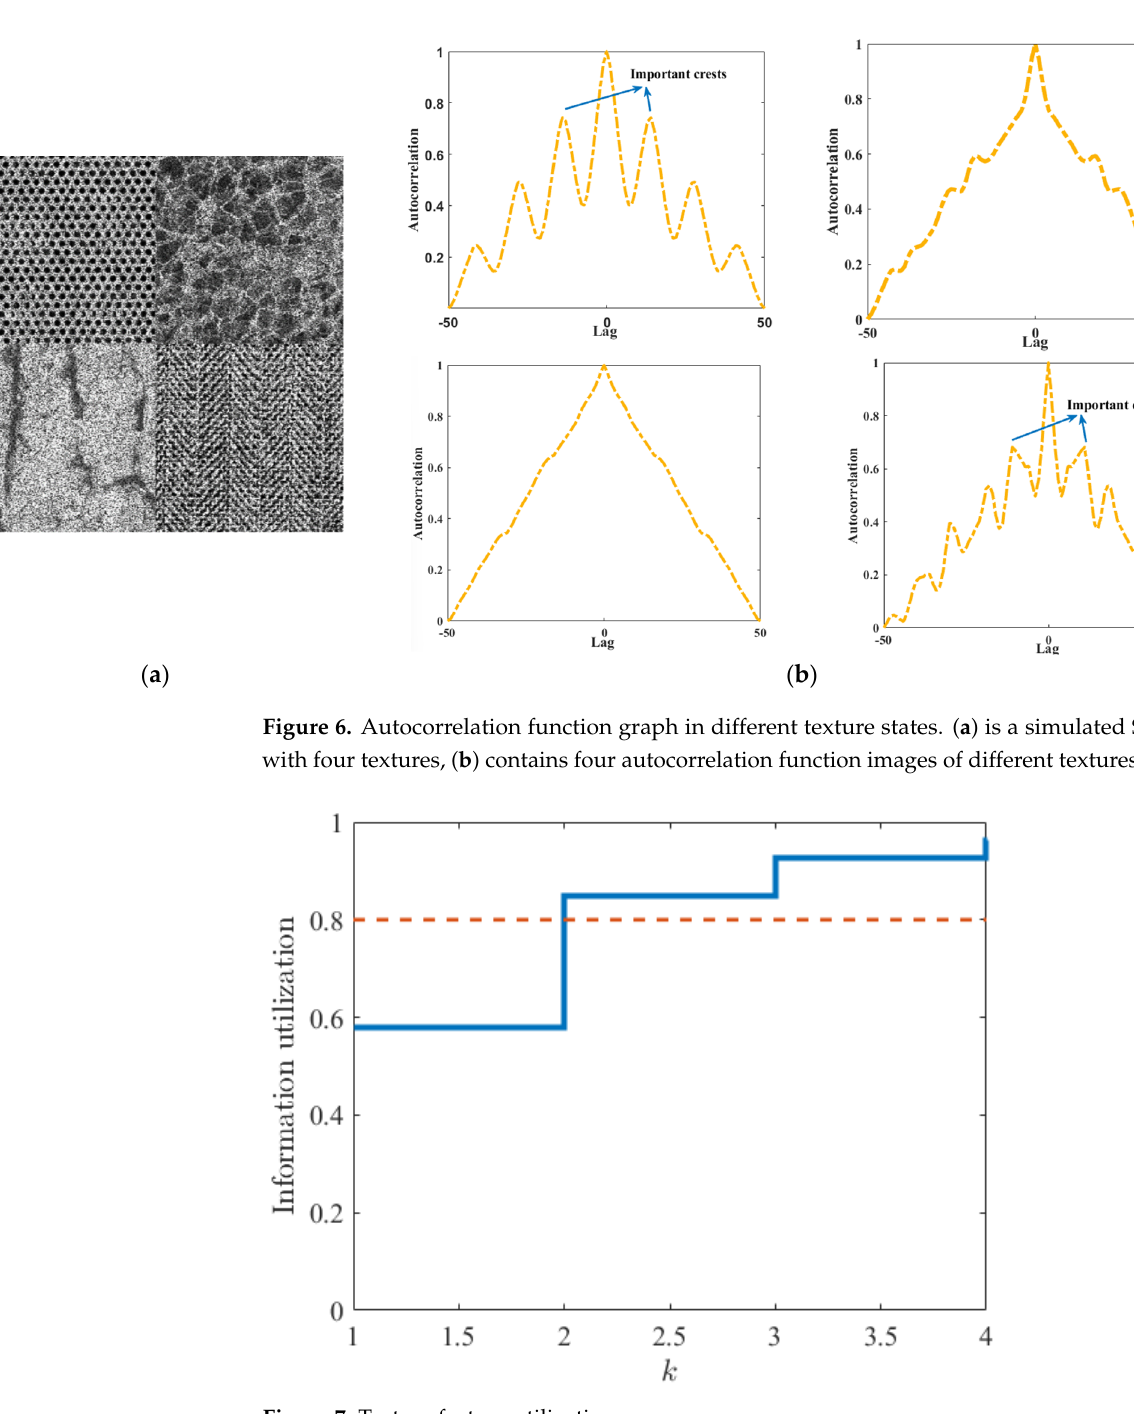
Figure 7. Texture feature utilization.